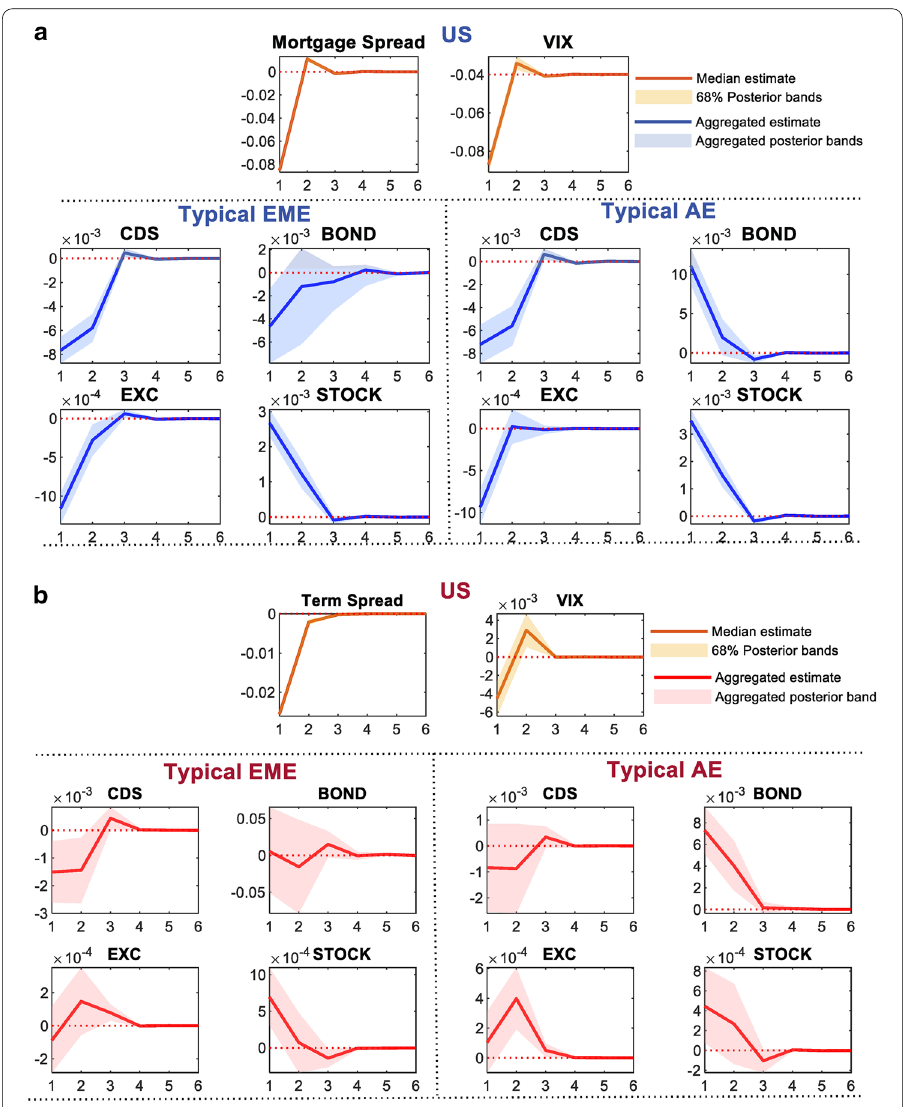
Fig. 6 Responses to US UMP indicators. a Responses of typical foreign financial markets and global risk appetite to a US mortgage spread shock. Notes : The upper panel shows the country-level (US) impulse responses to US mortgage spread shocks along with the 68% posterior probability bands. The lower panels indicate the average responses (Typical EME and AE) to such shocks. The average impulse response functions are calculated as a simple arithmetic average of the country-specific impulse response functions of 20 EMEs and 20 AEs reported in Appendix Fig. 13 (EMEs) and 14 (AEs). b Responses of typical foreign financial markets and global risk appetite to a US term spread shock. Notes: The upper panel shows the country-level (US) impulse responses to US term spread shocks along with the 68% posterior probability bands. The lower panels indicate the average responses (Typical EME and AE) to such shocks. The average impulse response functions are calculated as a simple arithmetic average of the country-specific impulse response functions of 20 EMEs and 20 AEs reported in Appendix Fig. 13 (EMEs) and 14